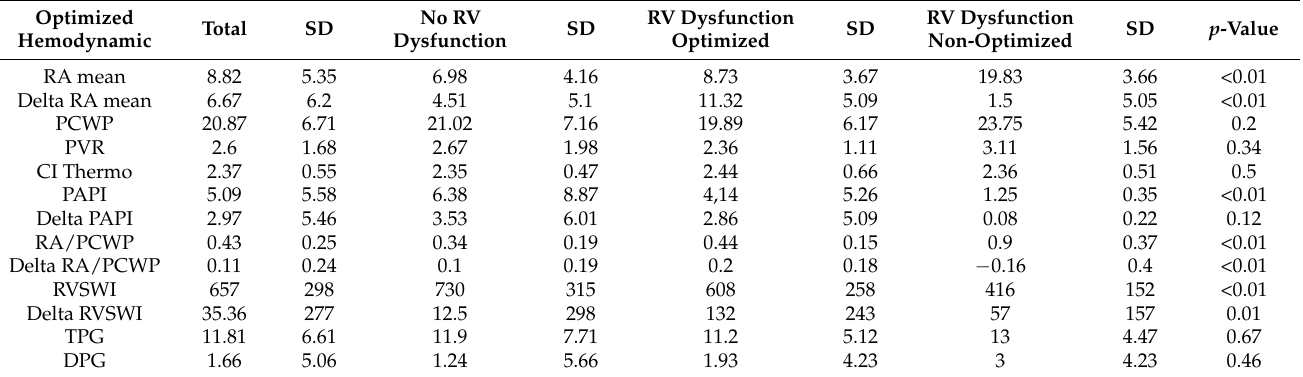
Table 2. Pre-LVAD hemodynamic optimization among patients without RV dysfunction, RV Dys- function and optimized hemodynamics and RV Dysfunction without optimized